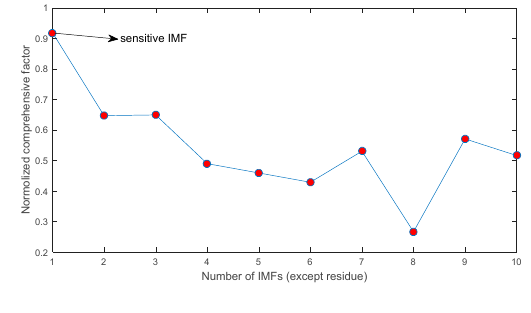
Figure 23. CF of each IMF.